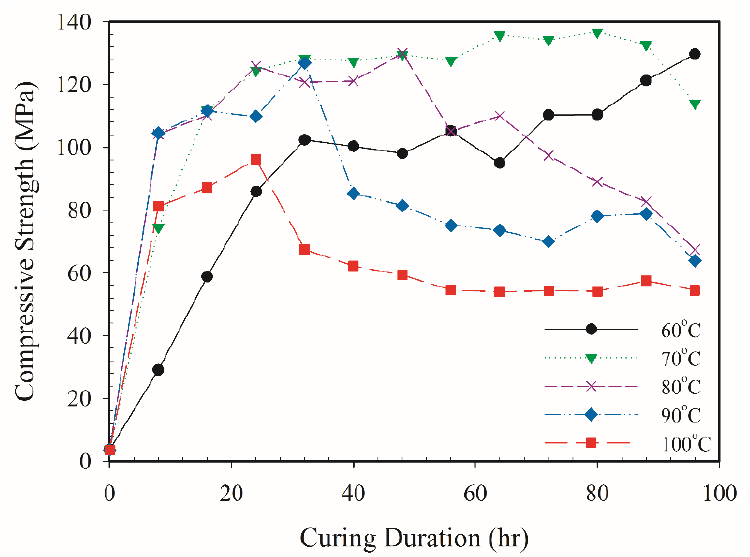
Figure 4. Variations with curing duration in the 4-day compressive strength of geopolymer speci- mens at various curing temperatures when AE% = 3%.